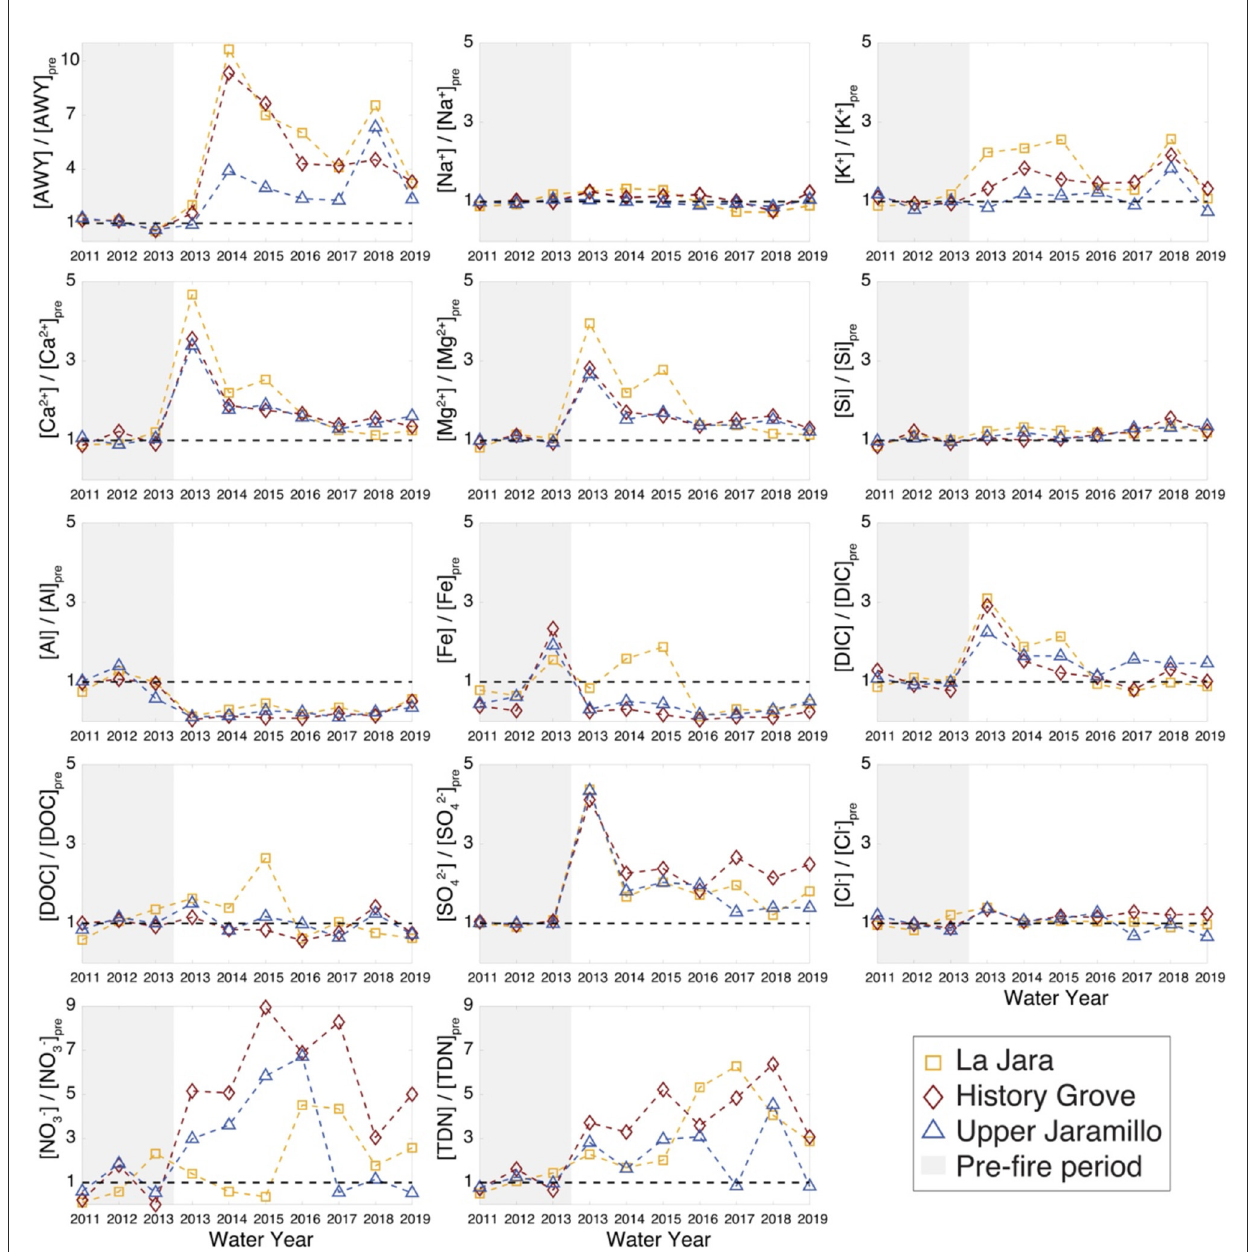
FIGURE6 Volume-weighted means (VWM) and annual water yields (AWY) of La Jara, History Grove, and Upper Jaramillo catchments normalized to pre-fire means (indicated by the subscript “pre”). Notice that water year 2013 shows two values of relative VWM and AWY in order to illustrate the immediate of the Thompson Ridge Wildfire in the summer of 2013 in the three headwater catchments at the